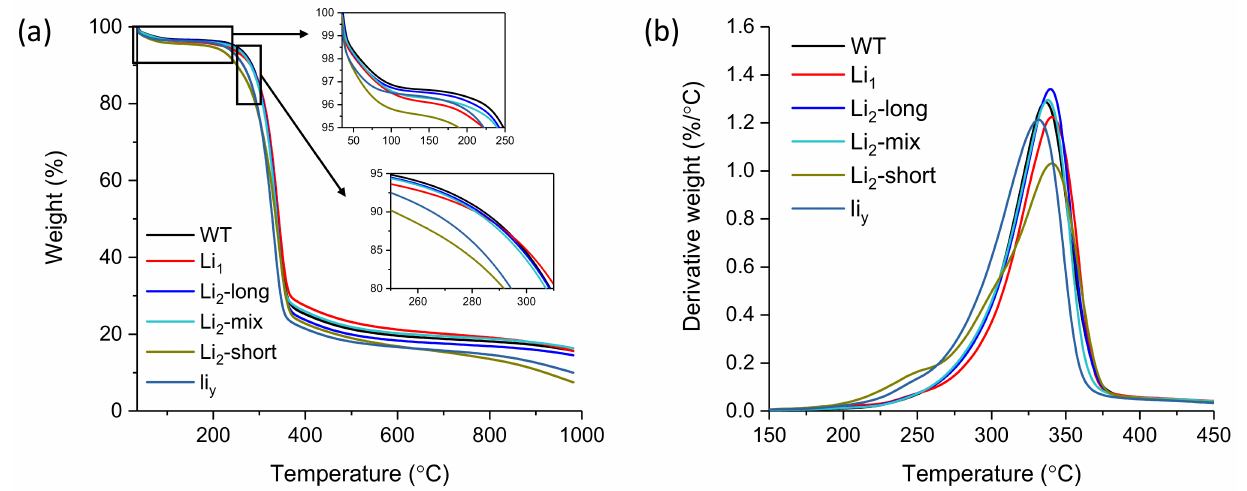
Figure 8. Thermograms of thermogravic analysis: ( a ) TG plots; ( b ) DTG plots. From the thermogravimetric analysis, eight quantitative parameters were determined (Table 2). The first two parameters were less impacted by the genetic mutation as their values were not so statistically significantly ( p ≤ 0.05) diverse than other